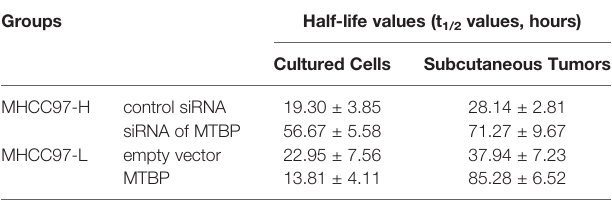
TABLE 2 | The effect of MTBP on the metabolism or the clearance of sorafenib in HCC cells. Groups